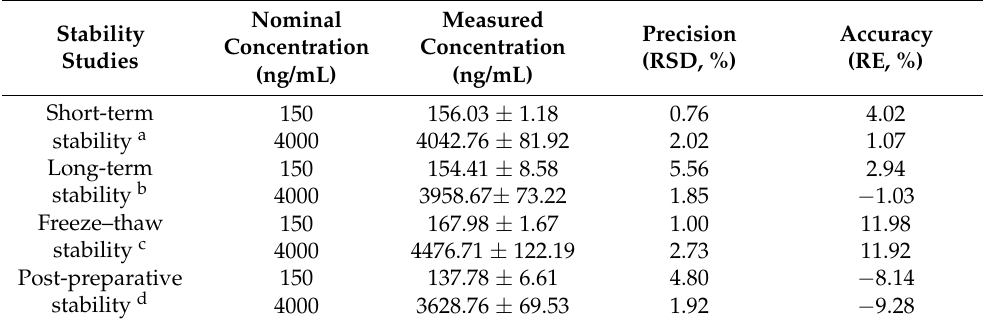
Table 4. The stability of GMDTC under various storage